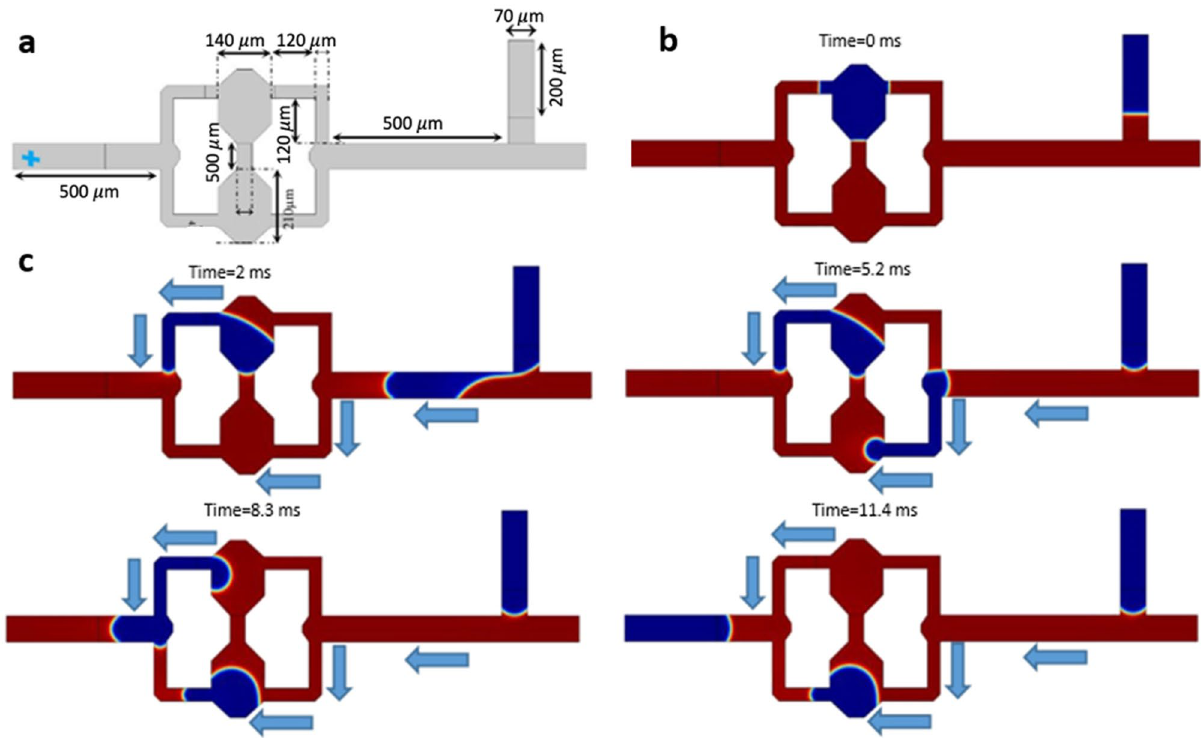
Figure 8. The microfluidic-based design of the Flip-Flop gate. ( a ) The design and geometry of the Flip-Flop gate. ( b ) A snapshot at t = 0. ( c ) Series of snapshots of the function of the Flip-Flop gate from t = 2 ms to t = 11.4 ms, and the sequence of bubble formation and direction. Activating one of the upper or lower cells in the Flip-Flop chip (by storing one bit of data (droplet)) represents the function of a microfluidic Flip-Flop gate as a memory